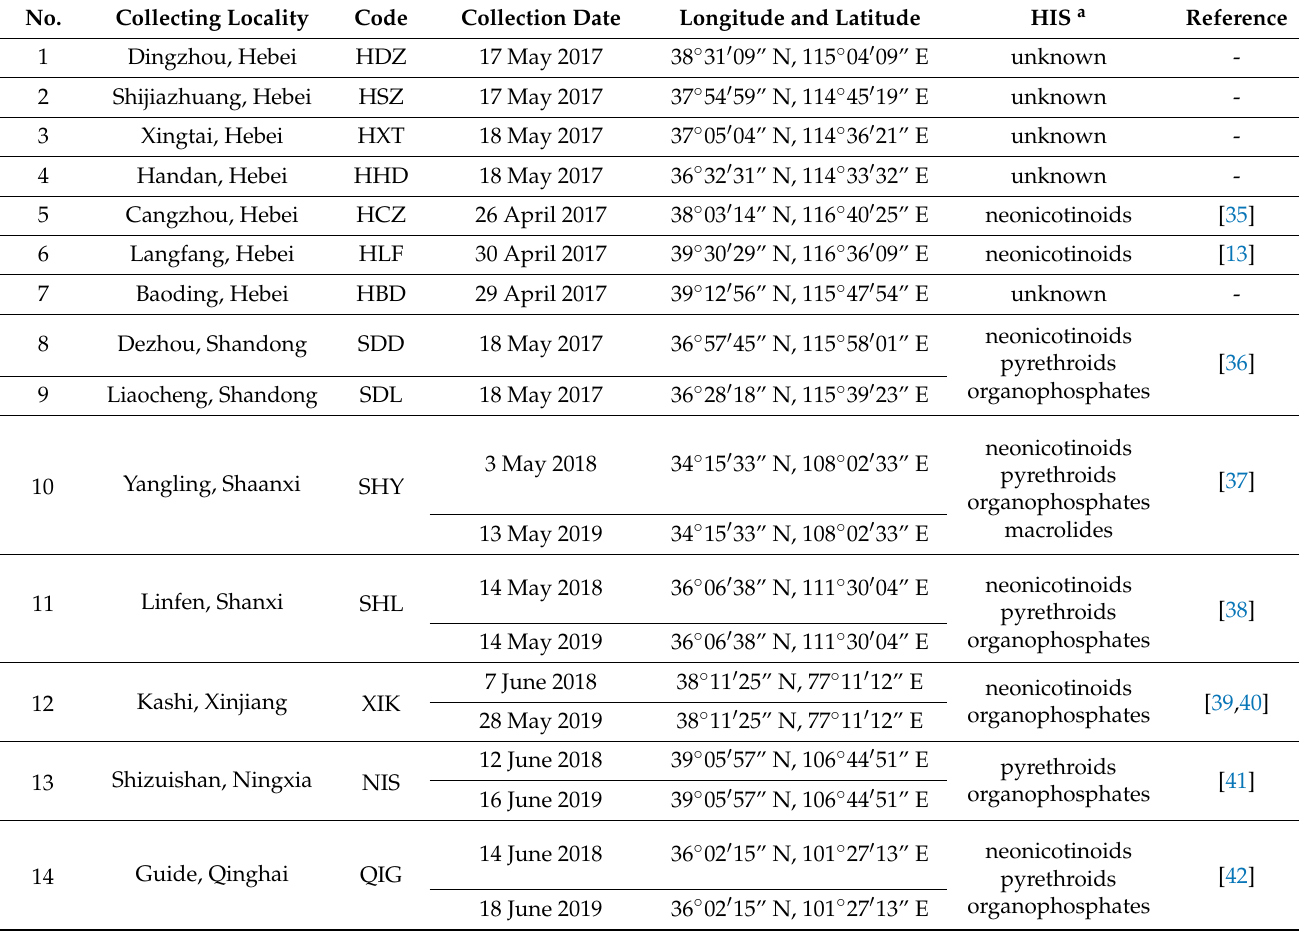
a : the history of insecticide usage.